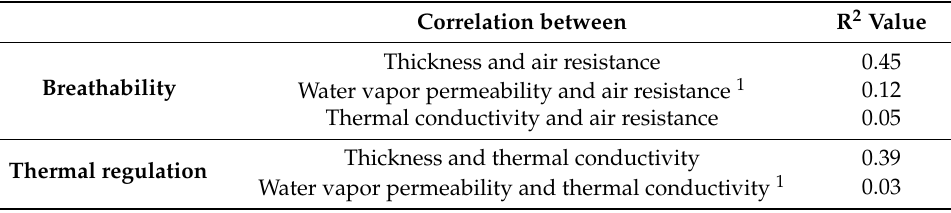
Figure 4. Thermal conductivity of different masks.